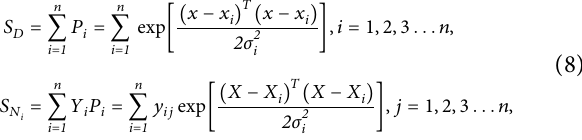
Figure 10: GRNN based predicted result.